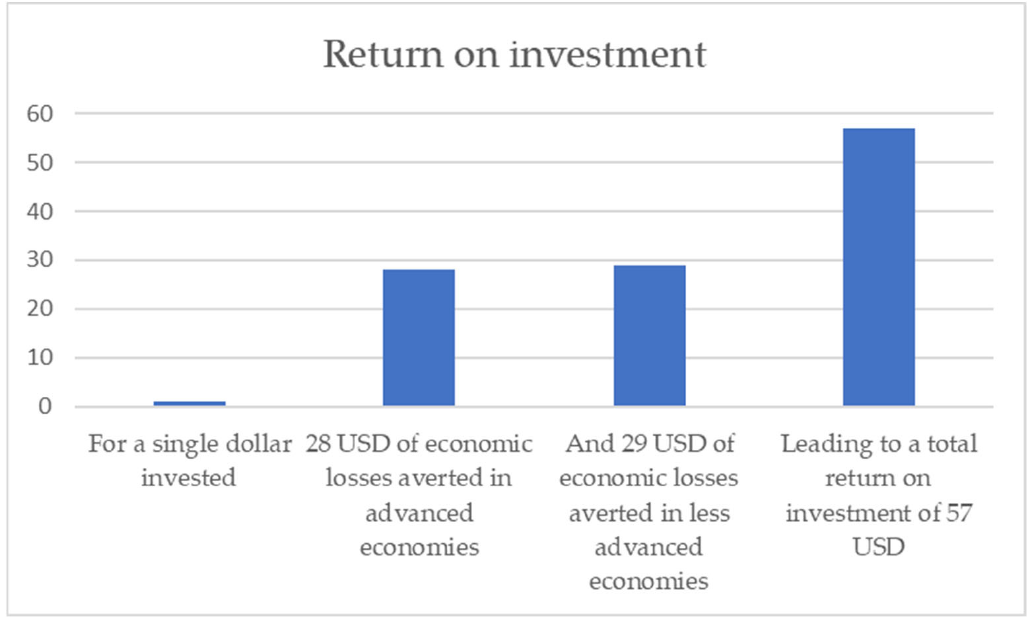
Figure 6. The return on investment to spending on broader and more equitable access to COVID ‐ 19 vaccines.